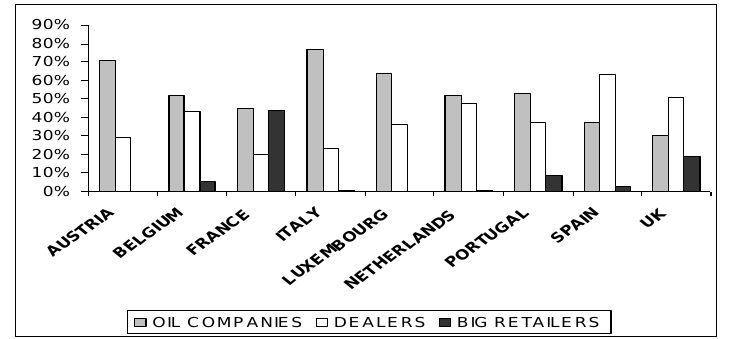
Figure 10: Ownership of Fuel Retail Sites in Selected European Countries –